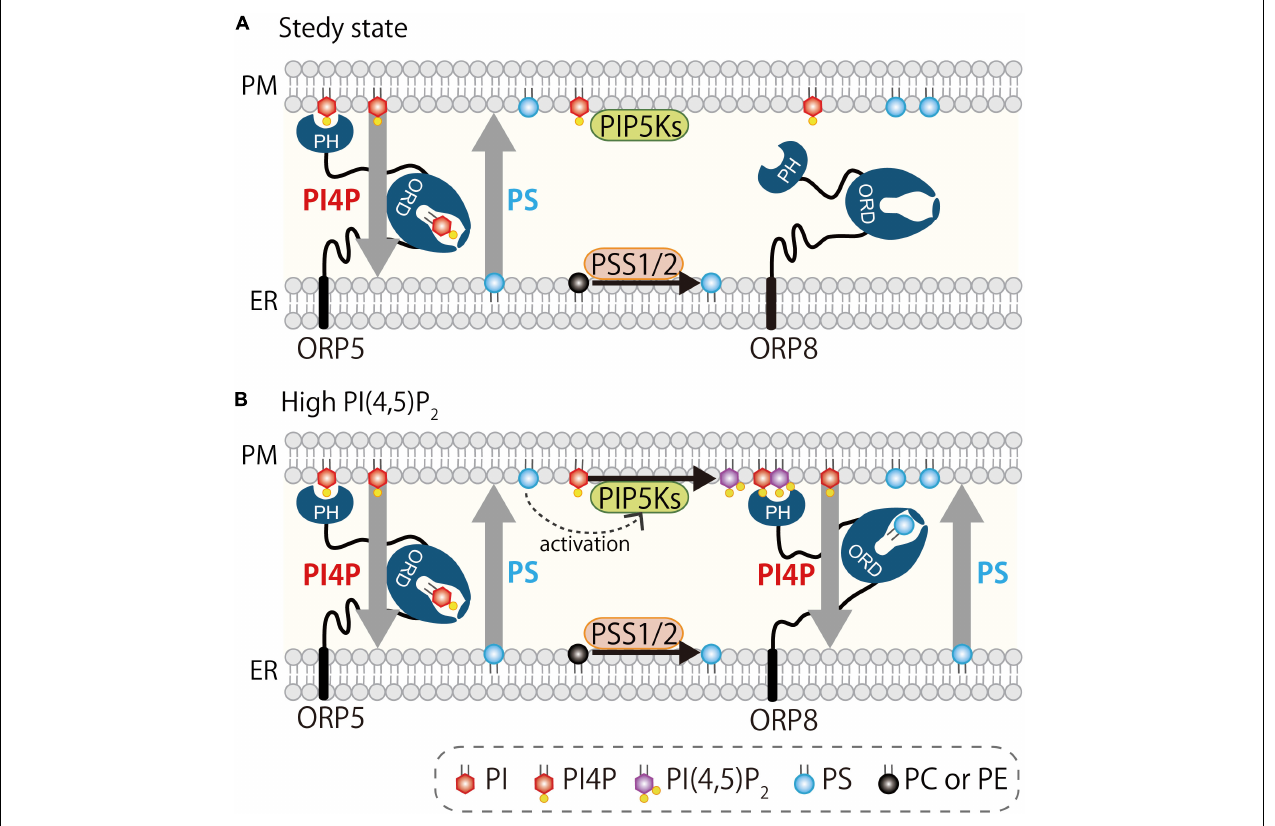
FIGURE 5 | Regulation of PI4P and PI(4,5)P 2 at the PM by oxysterol-binding protein-related proteins 5 and 8. (A) At steady state, ORP5 localizes at the ER–PM MCSs via binding to PI4P and PI(4,5)P 2 . (B) When PI(4,5)P 2 is high at the PM, ORP8 is strongly recruited to the PM via preferential binding to PI(4,5)P 2 and mediates countertransport of PI4P and PS. This reduces PI4P levels at the PM and thus contributes indirectly to reducing PI(4,5)P 2 levels by limiting its precursor. ORP8-mediated countertransport of PS to the PM may facilitate the activation of PIPKs (Nishimura et al.,